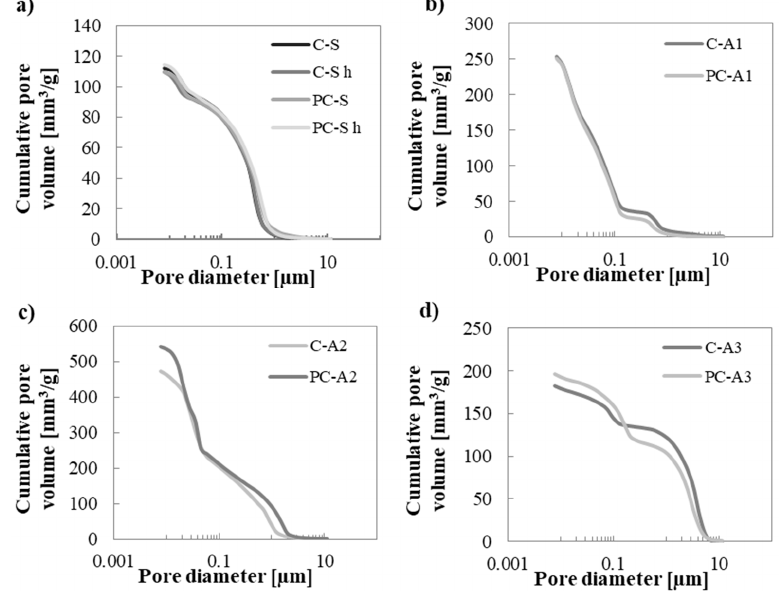
Figure 3. Cumulative pore volume distribution of mortars without hydrophobic admixture: ( a ) C-S, C-S h, PC-S, PC-S h; ( b ) C-A1, PC-A1; ( c ) C-A2, PC-A2; ( d ) C-A3,